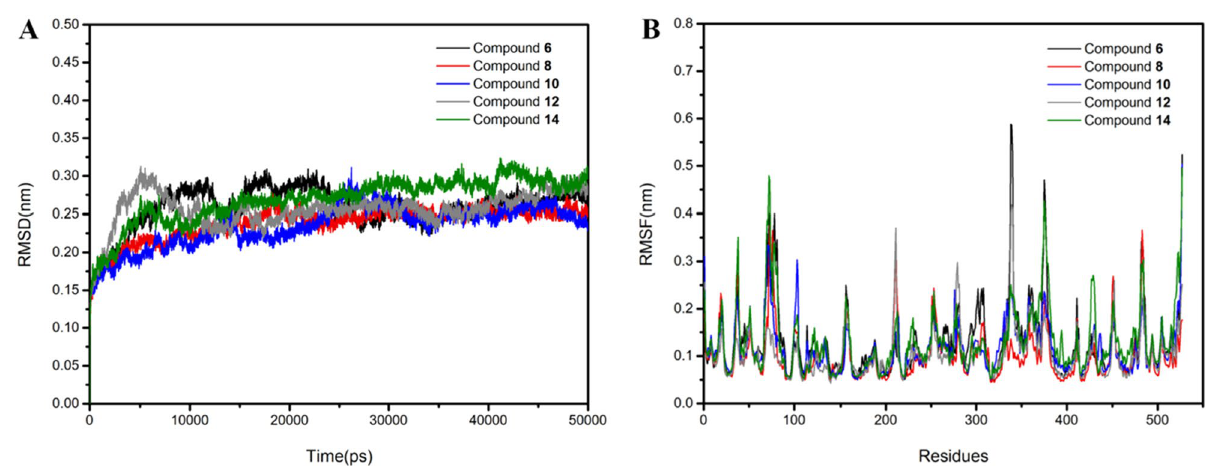
Figure 4. The RMSD ( A ) and RMSF ( B ) of five potent inhibitors with